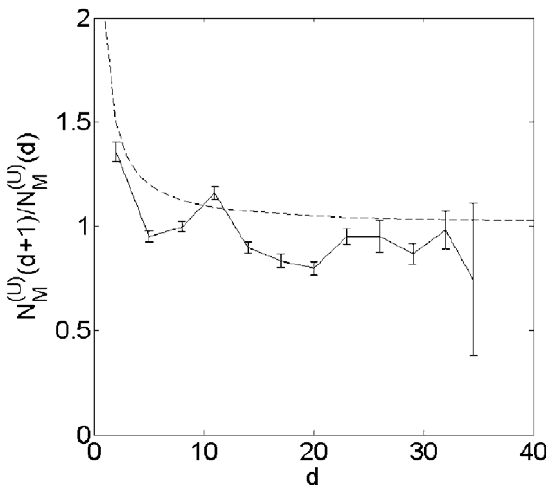
. Figure 6. N ( U ) d z 1 ð Þ N ( U ) d ð Þ vs. d for the universal network M M . d z 1 ð Þ N ( U ) d ð Þ of consisting of all KEGG reactions. The ratio N ( U ) M M the number of metabolites at two consecutive layers of the scope expansion process plotted versus the layer number d . Scope expansion was performed for the universal network consisting of all KEGG reactions. The dashed line is the mathematical expectation of the same curve in a critical branching process.